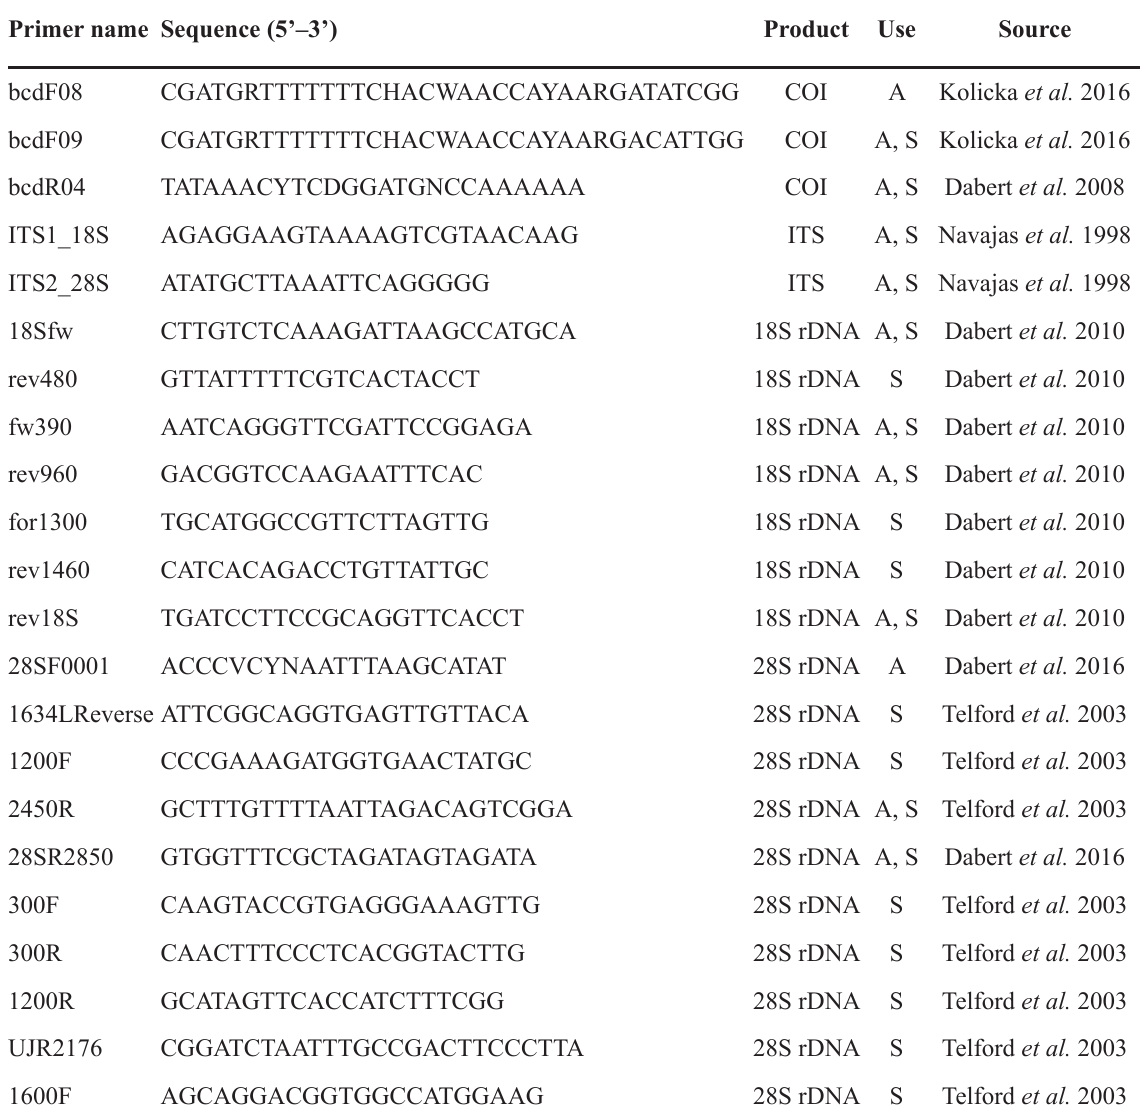
Table 2. PCR primers used in this study; A and S refer to amplifying and sequencing, respectively. Primer name Sequence